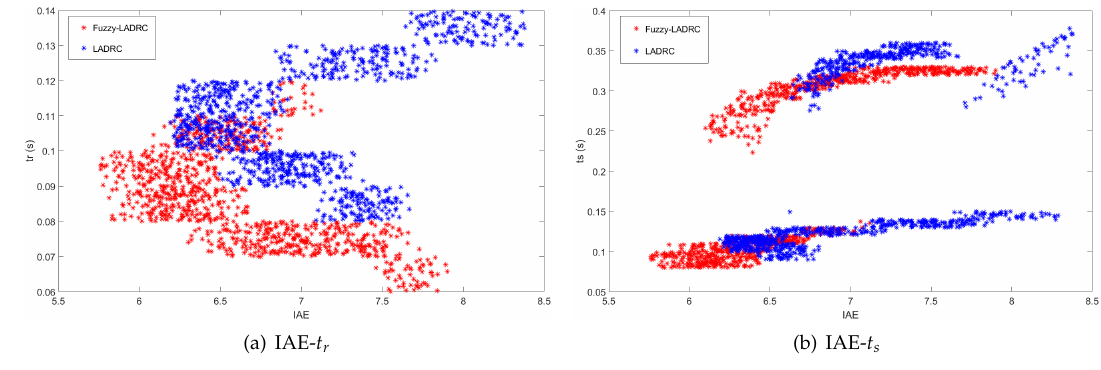
Figure 16. Monte Carlo experimental